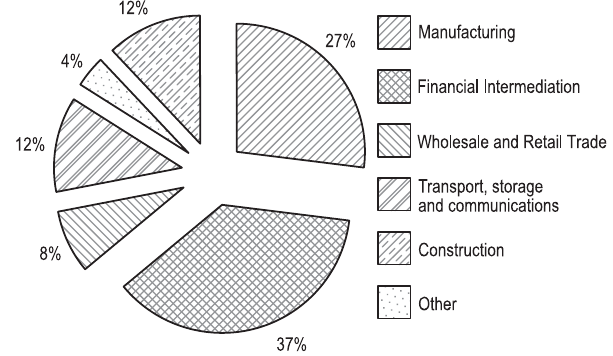
Fig. 2. Sectoral Distribution of MNCs – Survey Results – 2006. Other: agriculture, electricity, real estate, wholesale and retail trade